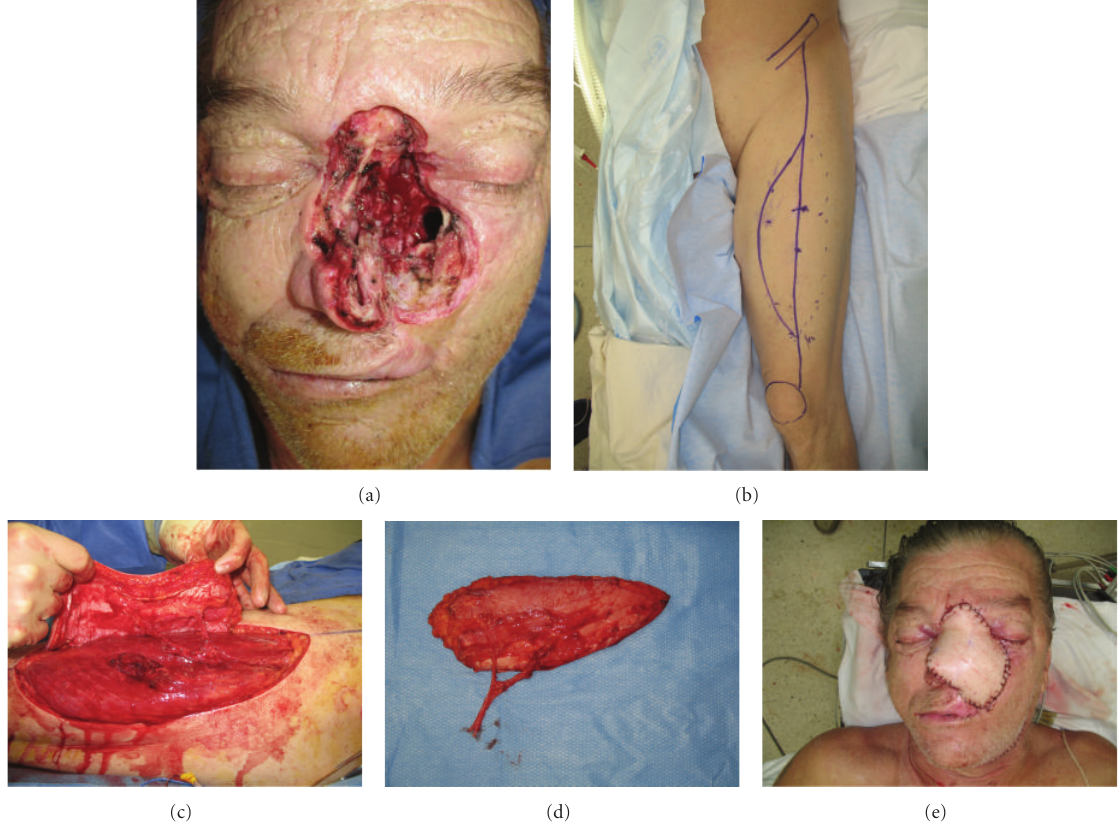
Figure 3: A 61-year-old male with a poorly controlled left facial basal cell carcinoma. (a) Maxillectomy defect; (b), (c), (d) ALT-free flap with long vascular pedicle; (e) inset of ALT-free